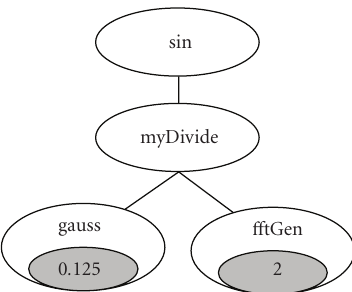
Figure 6: Example of a GP tree individual with two RECs (in grey